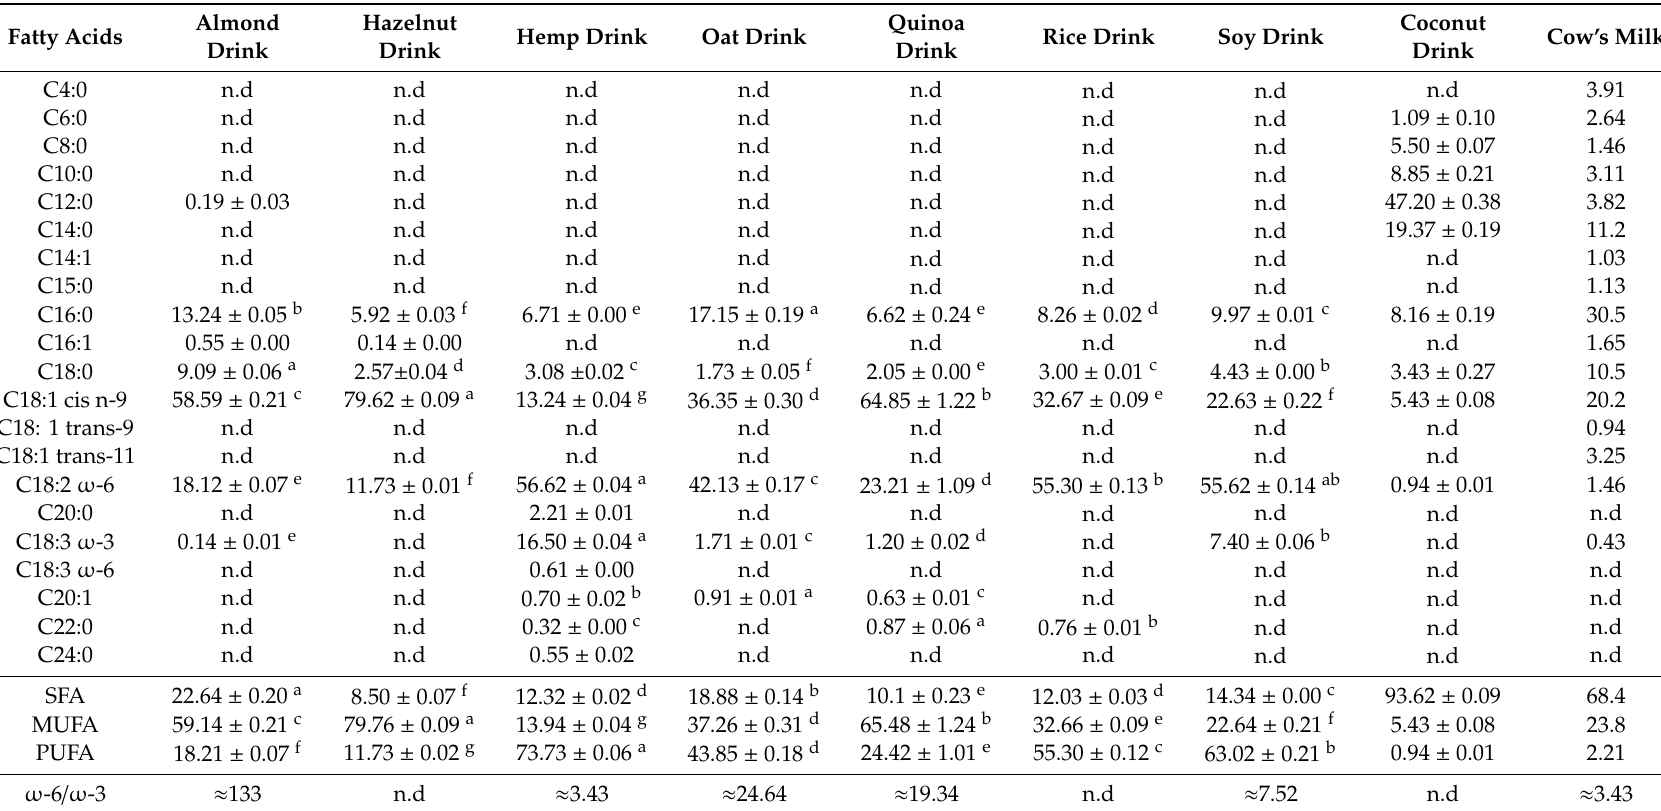
Table 2. Fatty acid profiles of commercial plant-based milk alternatives (g / 100 g total fatty acids by product). Fatty acid profile of full fat cow’s milk (3.5% fat) has been included from the Danish National Food Institute